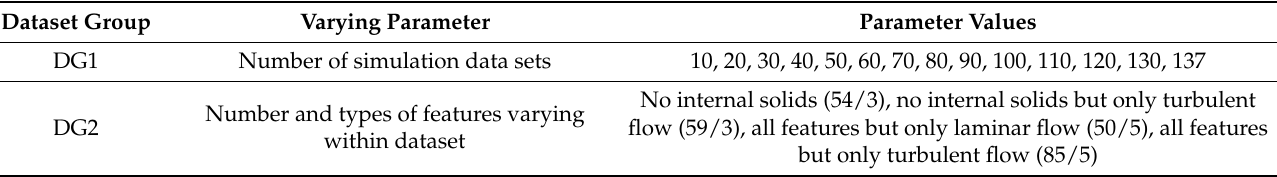
Table 5. Groups of datasets used for model evaluation. For the group that varies in the number of features (DG2), more detailed information is given in brackets in the following format: (Number of simulation datasets, number of features varying within these